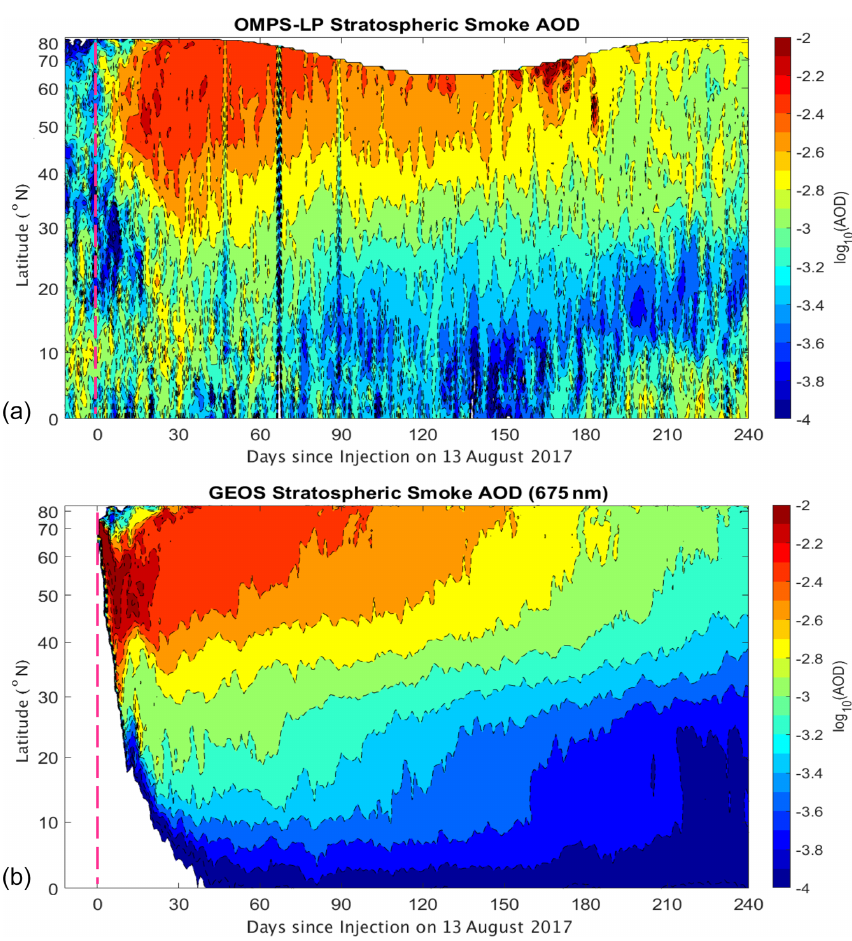
Figure 9. Hemispherical spread and residence time of pyroCb smoke. Zonal mean of stratospheric smoke AOD (a) retrieved from OMPS- LP and (b) simulated by the GEOS model over the Northern Hemisphere for about 8 months after the injection, during which OMPS-LP observed significantly enhanced values of aerosol extinctions compared to the